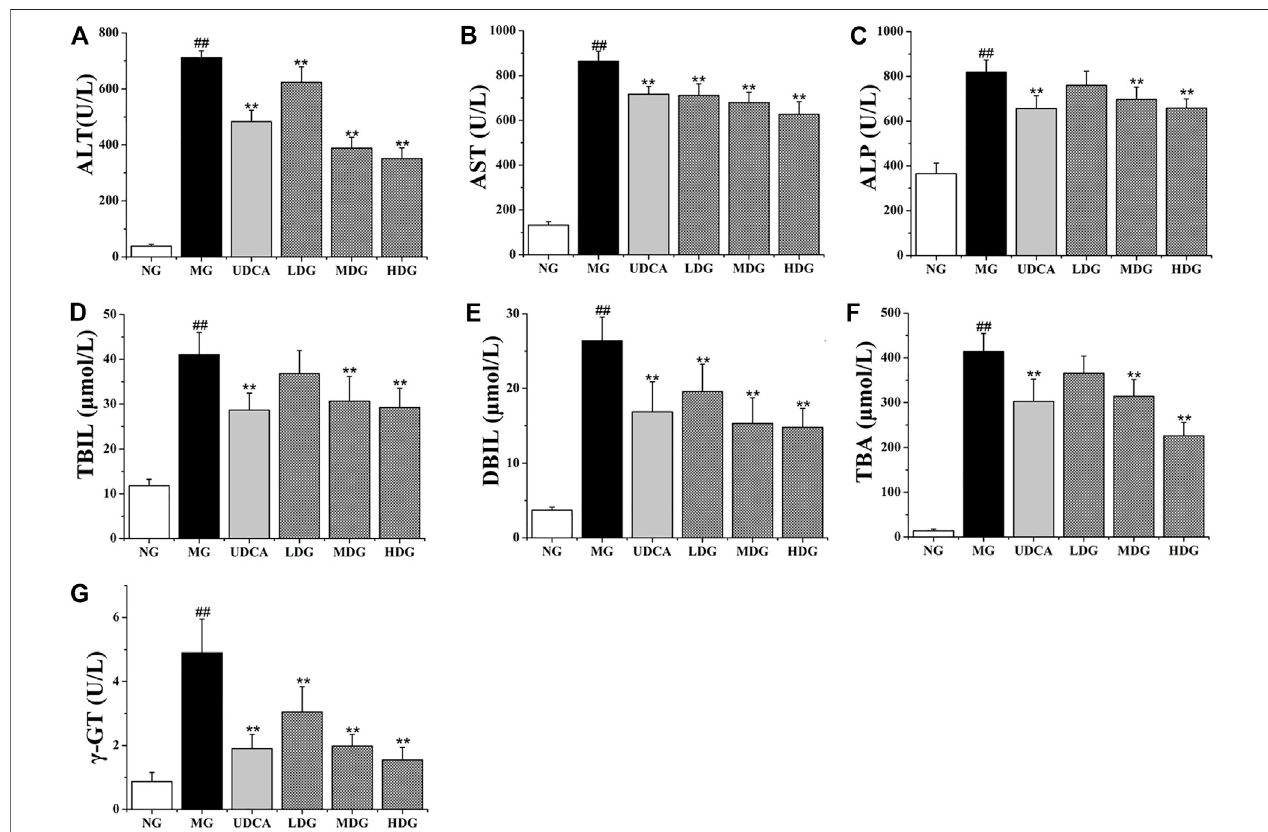
FIGURE2| TheeffectsofHGJDonserumbiochemistry.ThebiomarkersofliverinjuryandbiliarycelldamageintheserumbiochemistrywereALT (A) ,AST (B) ,ALP (C) , TBIL (D) , DBIL (E) , TBA (F) and γ -GT (G) . Data are expressed as the Mean ± SD ( n (cid:1) 6 in each group). ## p < 0.01 compared with the normal group; ** p < 0.01 compared with the model group.